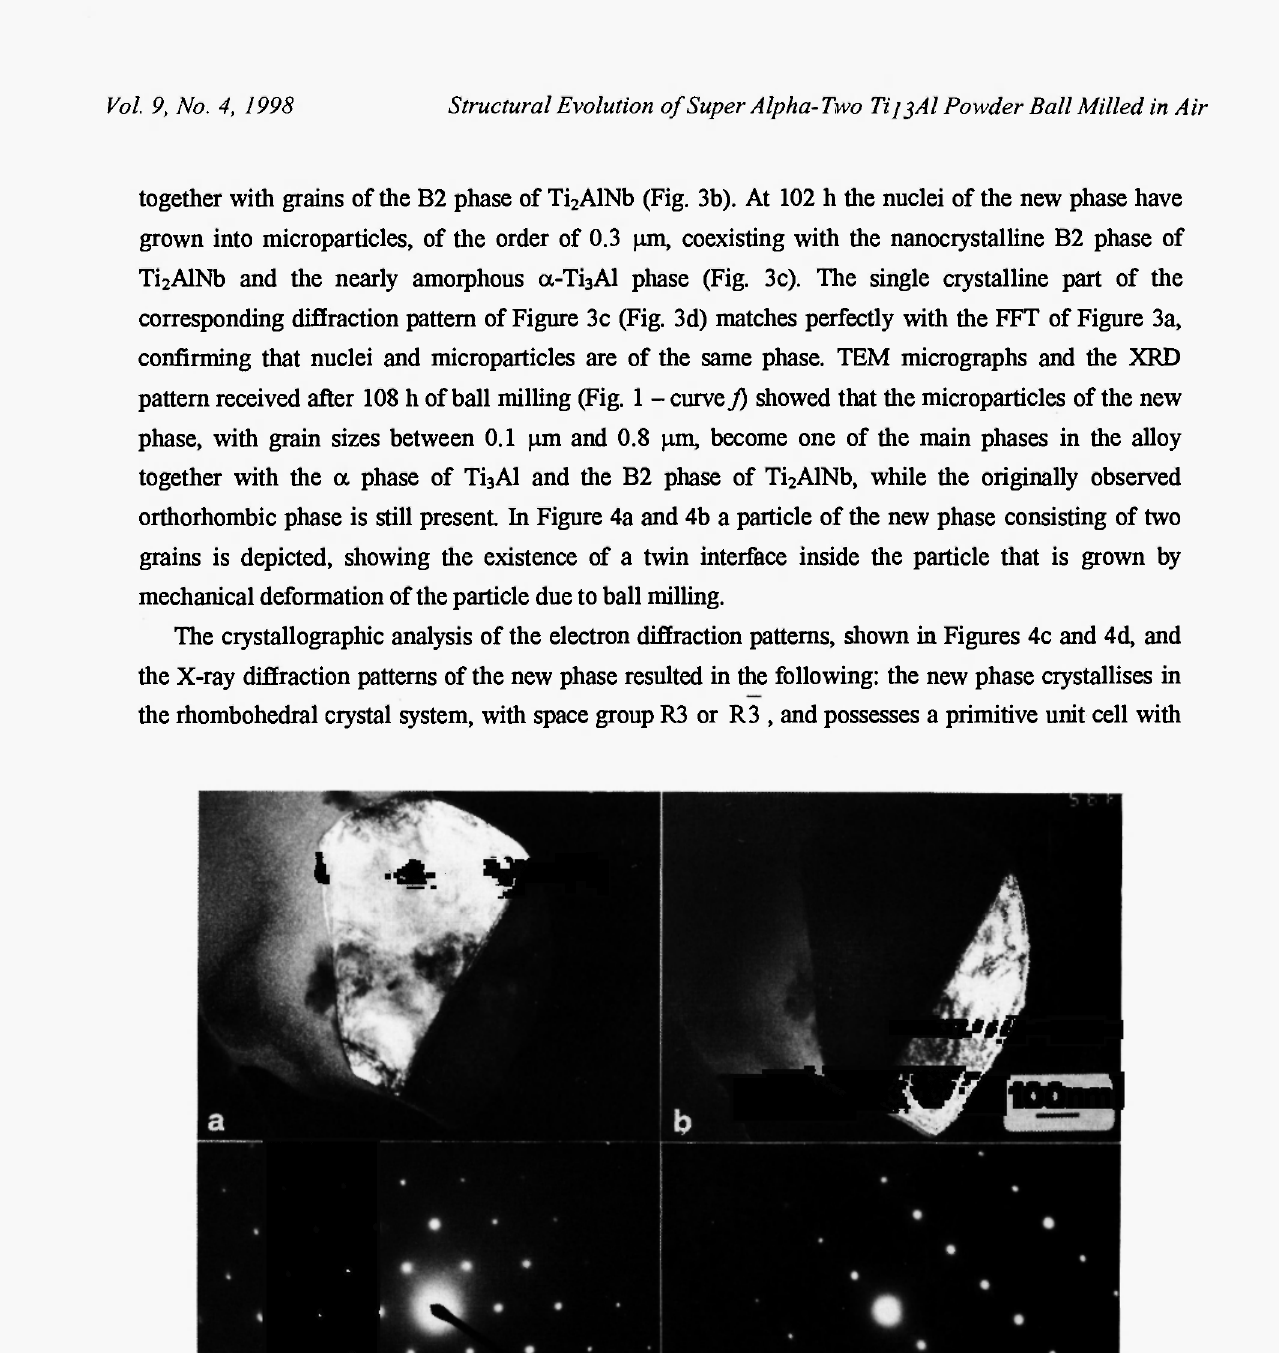
Fig. 4: a) Dark field (DF) image of a particle of the new phase that contains an interface, after 108 h of ball milling, b) DF image of the other grain of the bicrystal. c) Diffraction pattern of the new phase with the [0111] zone axis oriented parallel to the electron beam, d) Diffraction pattern of the new phase with the [3300] zone axis oriented parallel to the electron